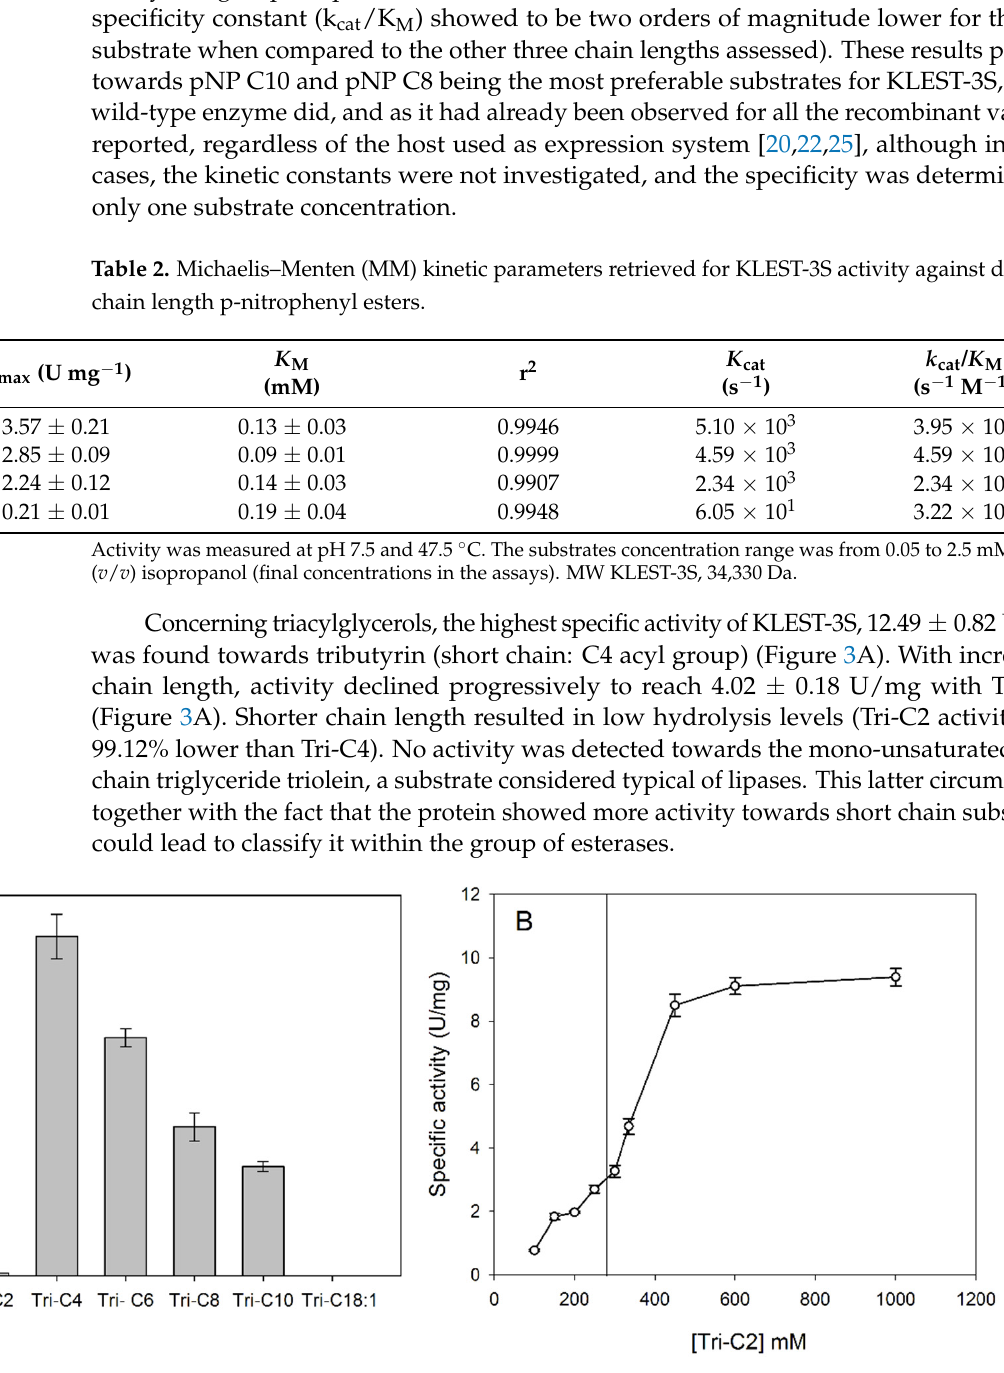
Figure 3. KLEST-3S substrate specificity on different triacylglycerides and kinetic profile on tri- acetin. ( A ) Specific activity of KLEST-3S towards several triacylglycerols. Activity was measured in pH-stat at 40 °C and pH 8.0 using emulsions of each triacylglycerol (20 mM concentration), stabi- lized with gum arabic. ( B ) Dependence of KLEST-3S specific activity on triacetin concentration. Ac- tivity was measured in pH-stat at 40 °C in 5 mM Tris-HCl buffer (pH 8.0) containing 40 mM CaCl 2 and variable amounts of triacetin. The triacetin solubility limit (270 mM) is indicated by a vertical line. In both cases, data are expressed as mean values of three replicates for each substrate or tri- acetin